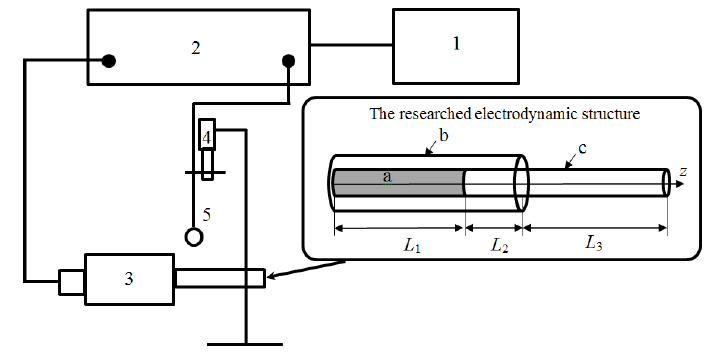
Fig. 1. The structural scheme of the experimental